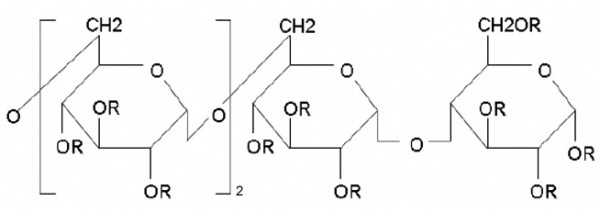
Chemical structure of IMOS. R: SO3Na or H